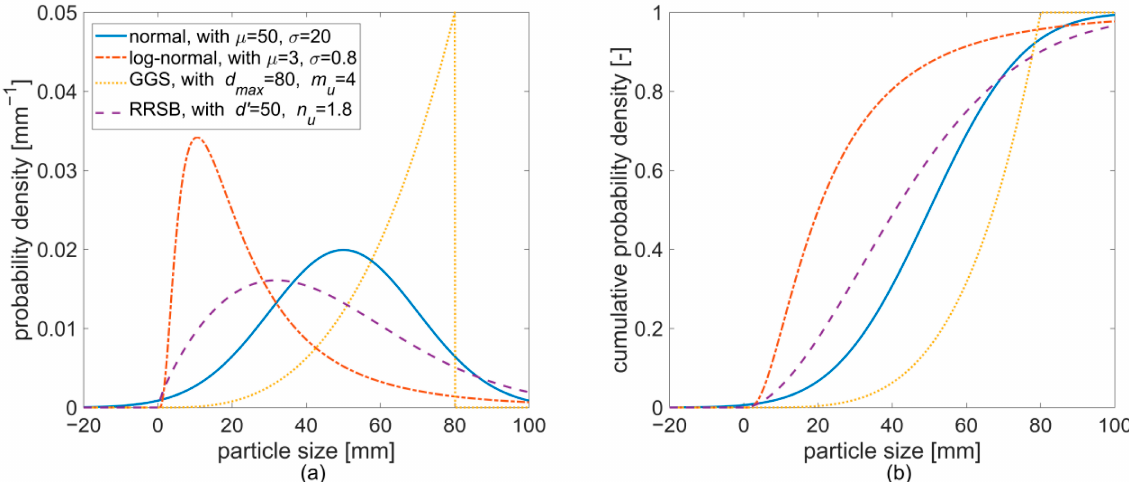
Figure 2. Frequency density ( a ) and cumulative frequency density ( b ) of a normal, log-normal, Gates-Gaudin-Schuhmann (GGS), and Rosin-Rammler-Sperling-Bennet (RRSB) distribution.